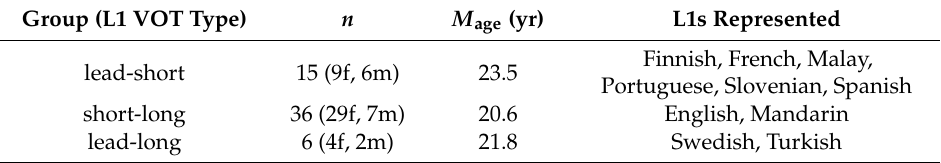
Table 3. Background information on participant groups in the stop study.